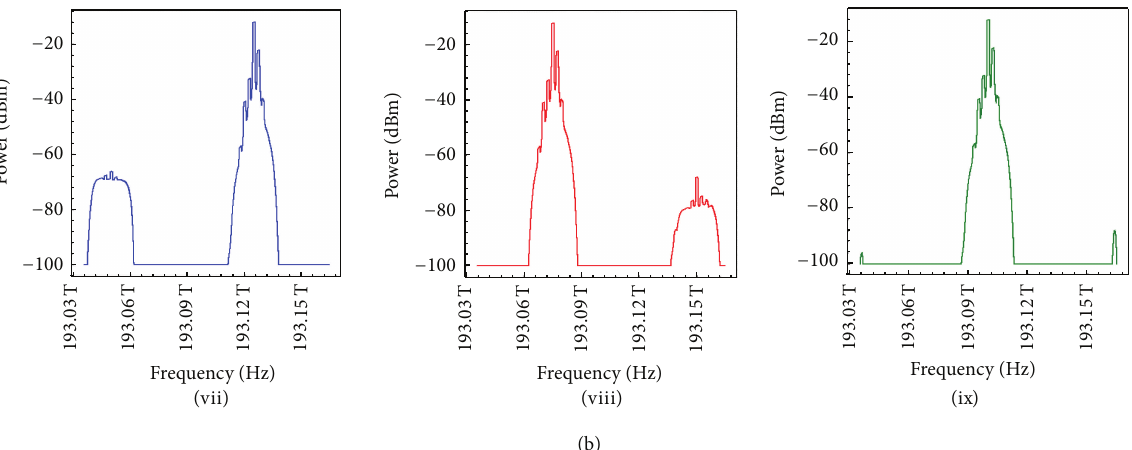
Figure 3: Transport of wireless MIMO signals over optical fiber using the OFU technique: (a) block diagram of the proposed technique and (b) power spectra of the signals according to the indicated